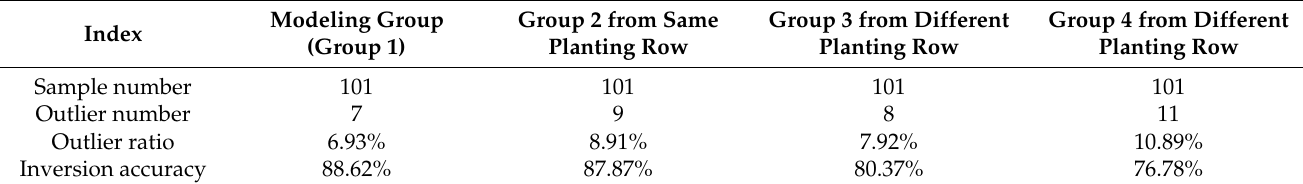
Table 2. Analytical results of inversion accuracy of the inversion model of Y21 for the samples of four groups.